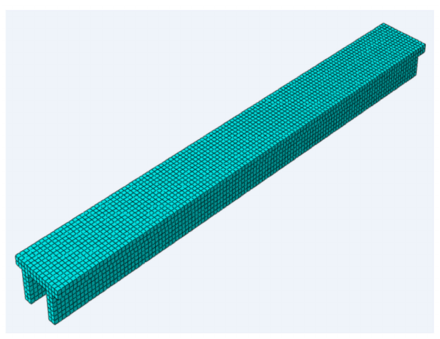
Figure 2. Finite element